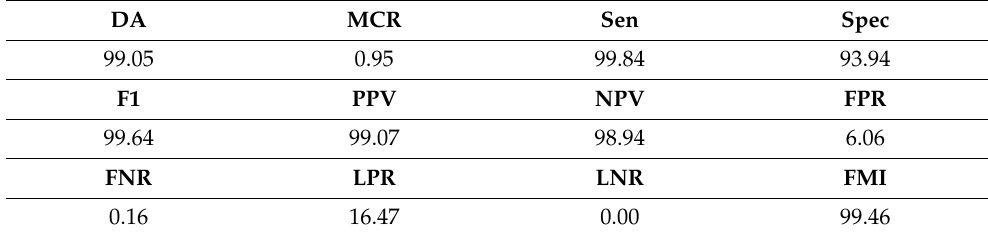
Table 8. Performance Analysis of SVM (%) During Testing Phase.